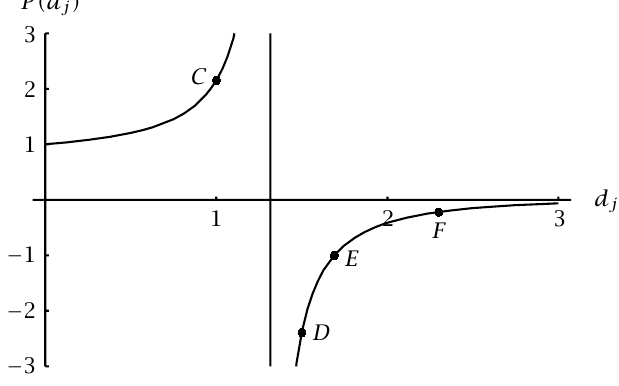
Figure 6.2 . Product ratio P(d j ) for b(t) = b cos (πt) , | b | > 1 and small.